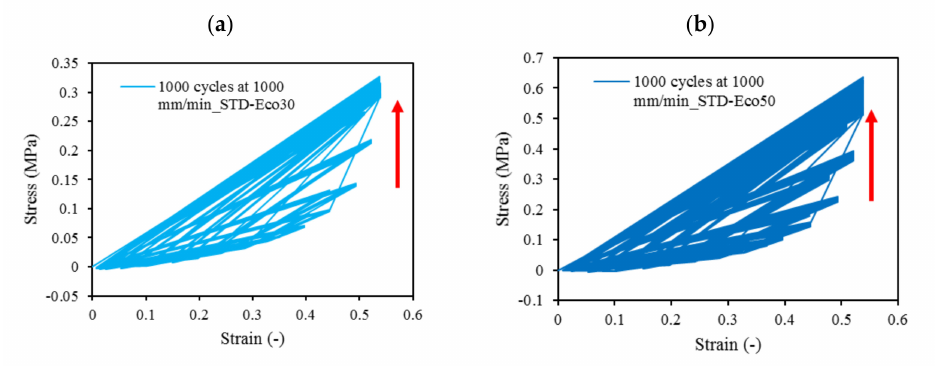
Figure 13. 1000-cycle cyclic stress-strain for ( a ) STD-Eco30 and ( b ) STD-Eco50, at a strain rate of 1000 mm / min.